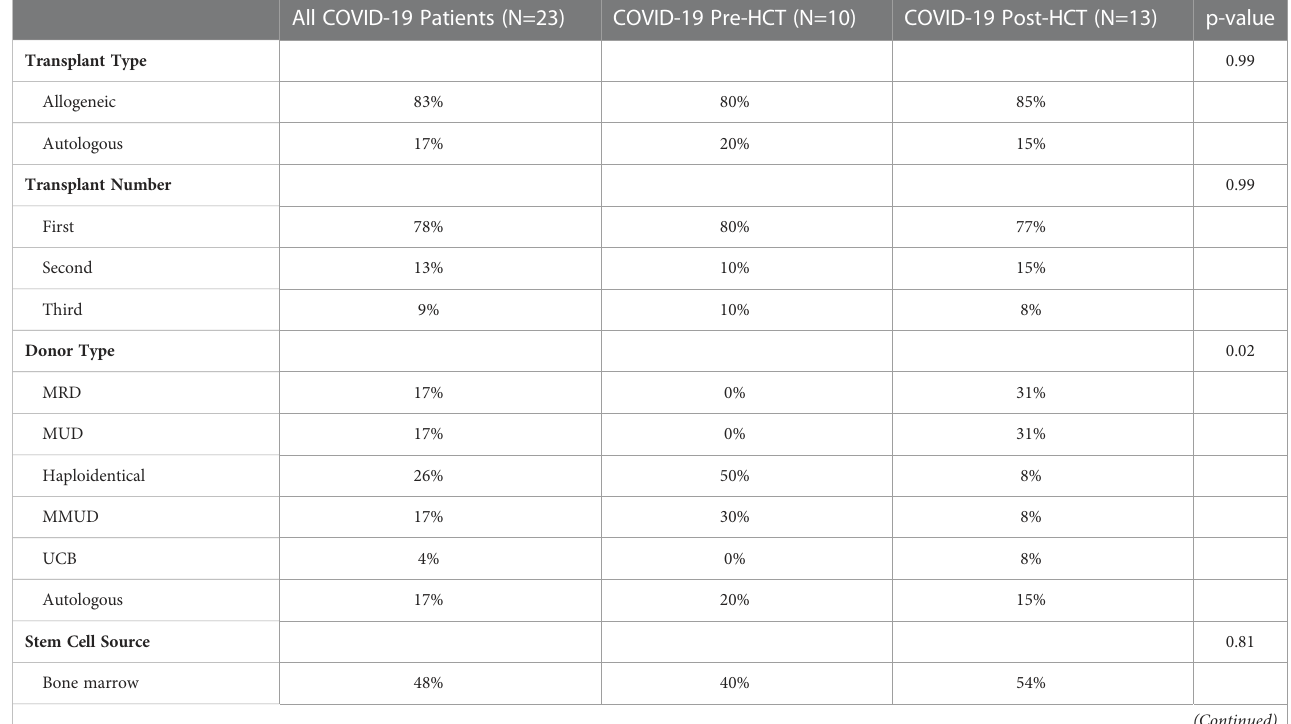
TABLE 1B HCT variables of patients who contracted COVID-19 pre- and